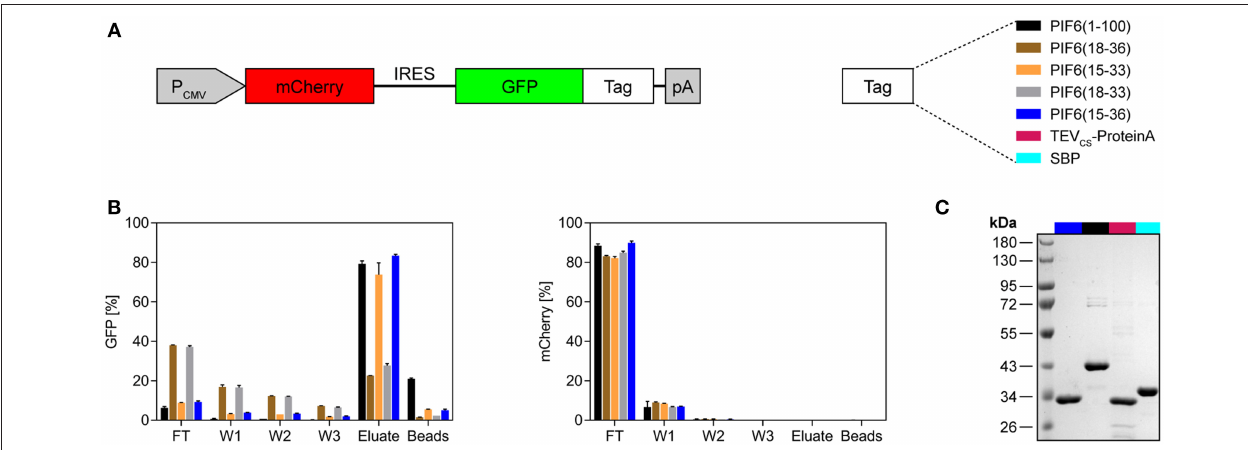
FIGURE 2 | Evaluation of different truncated variants of PIF6 for the application as an affinity tag. (A) Design of the expression construct for testing of different affinity tags. GFP was fused to the depicted PIF6 variants or to the affinity tags TEV CS -ProteinA or SBP. The fusion proteins were expressed together with the untagged red fluorescent protein mCherry by a constitutive CMV promoter in human embryonic kidney cells (HEK-293T). IRES, internal ribosomal entry site; pA, poly(A) tail. (B) Monitoring of the light-controlled affinity purification process. Fluorescence of GFP and of the background control mCherry was measured using a plate reader and is shown as percentage normalized to the fluorescence of the initial cell lysate. For each replicate, 4 × 10 6 cells were lysed in 500 µ l lysis buffer and proteins were purified with 50 µ l of PhyB* beads. The proteins were eluted at 740nm light for 30min. FT, flow-through; W1-W3, wash 1-3. Data are means ± s.d. ( n = 2). (C) Comparison of the purity of light-controlled affinity purification [PIF6(15-36) and PIF6(1-100)] with established purification methods (TEV CS -ProteinA and SBP). For each purification, 125 × 10 6 cells were lysed with 500 µ l of lysis buffer and purified with 100 µ l of beads and four washing steps. Coomassie-stained SDS-PAGE gel of the eluates is shown.